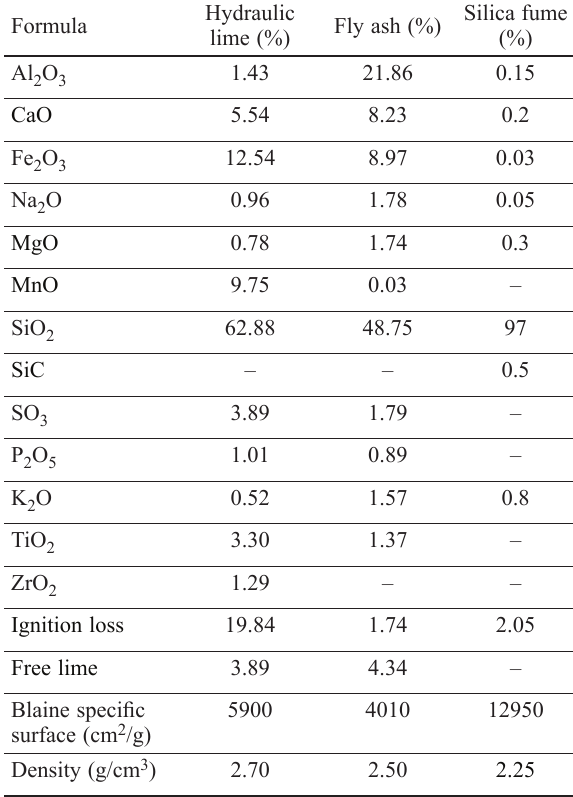
Table 2. Chemical characterization of hydraulic lime, fly ash and silica fume Formula